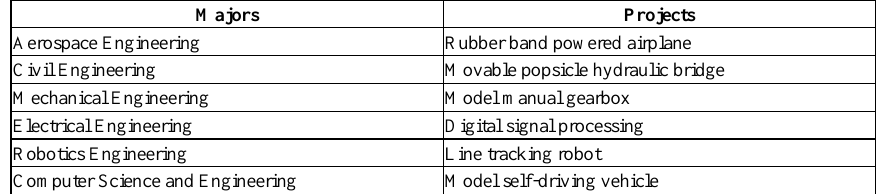
Table 1. A list of projects related to each engineering major.